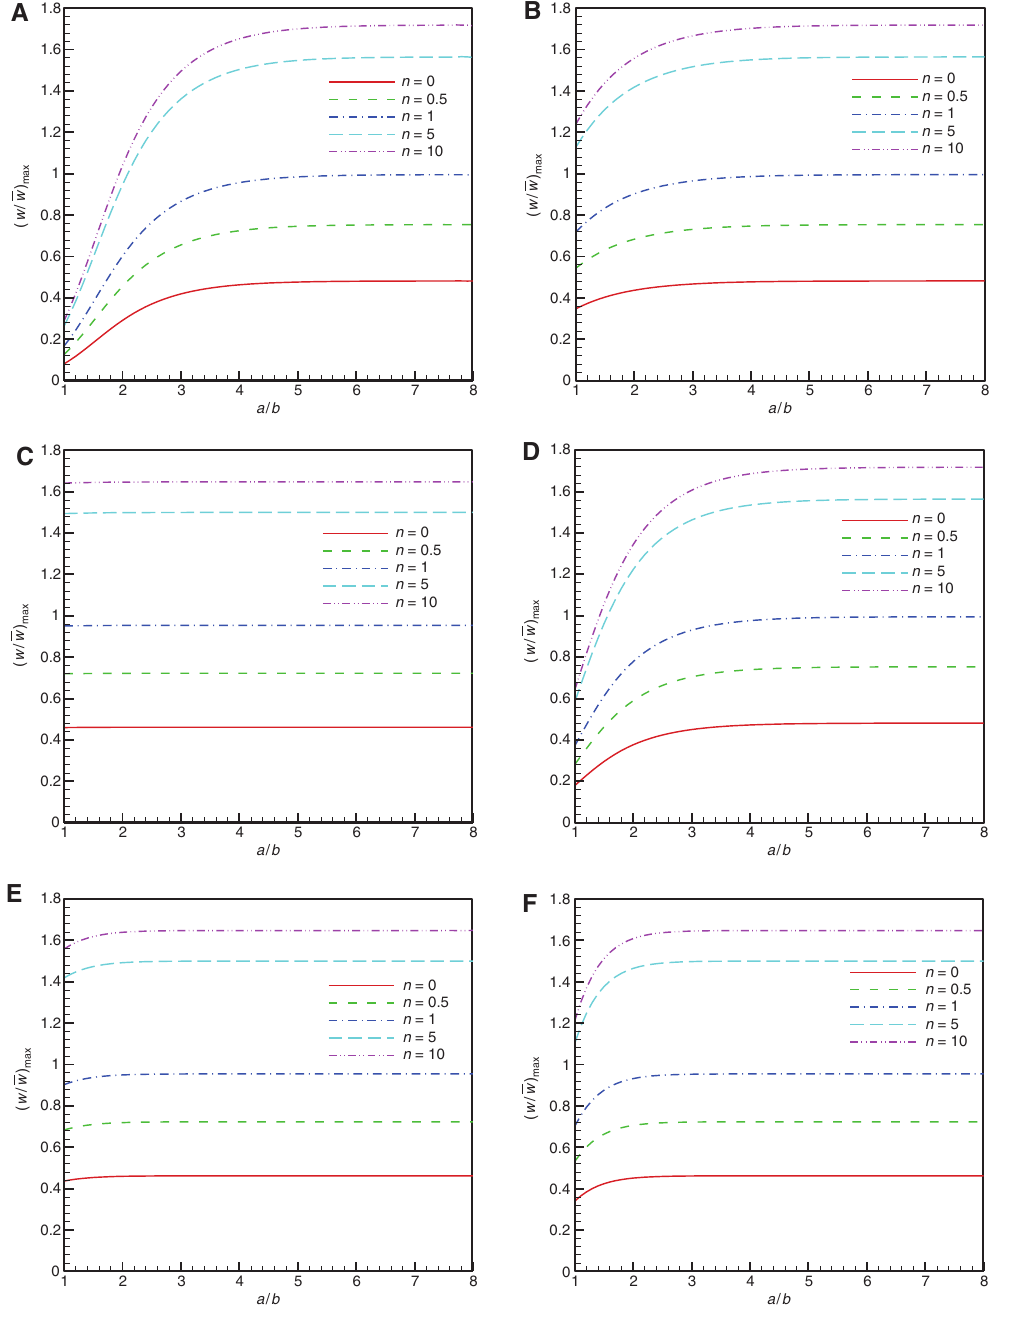
Figure 2: Non-dimensional deflection vs. variation of aspect ratio. (A) SCSC micro-plate, (B) SSSS micro-plate, (C) SFSF micro-plate, (D) SSSC micro-plate, (E) SSSF micro-plate, and (F) SFSC